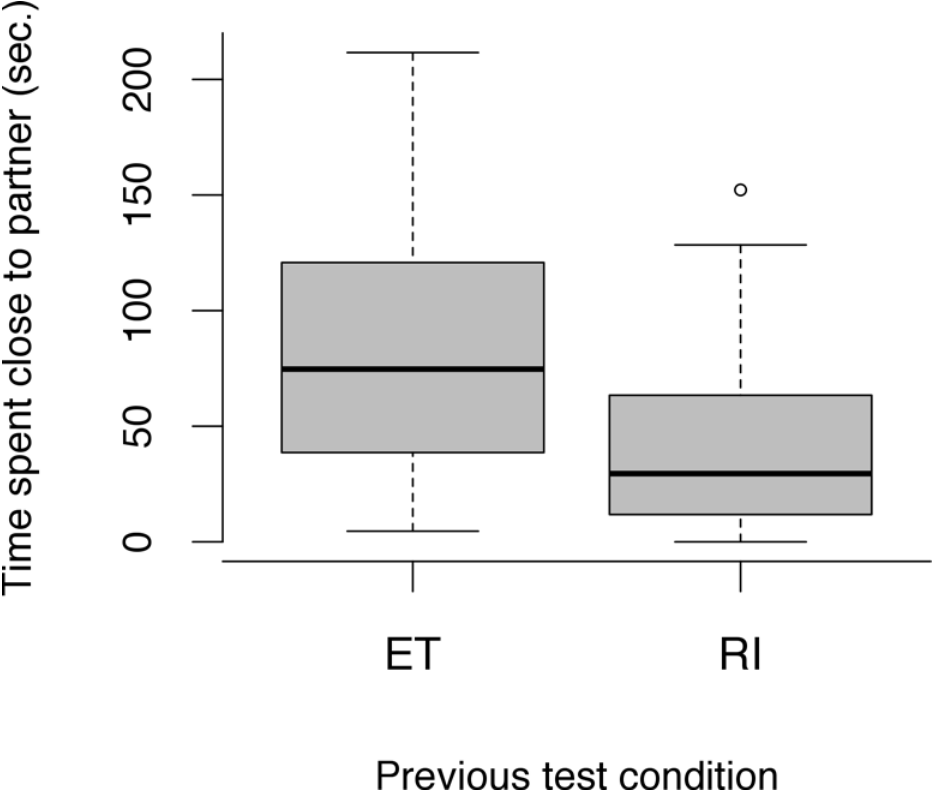
Fig 7. Proportion of time spent in close proximity to the partner dog during the break time following the equity (ET) and reward inequity (RI) condition. Circles show outliers, black bars indicate median values, whiskers display upper and lower hinge, and boxes show the interquartile